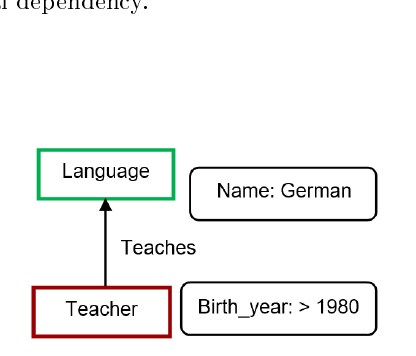
Fig. 8: Integrity constraint